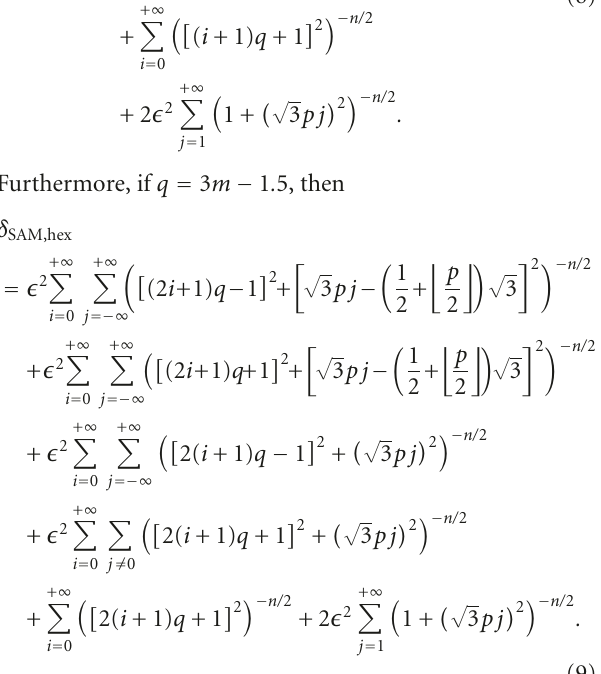
Figure 2: A network on the hexagonal grid with the spacing d hex meters between two adjacent nodes. Under the SAM, data pack- ets are transmitted from the black nodes to their neighboring gray nodes during a time slot. The horizontal spacing between two ac- tive transceivers is qd hex , and the vertical spacing between two active √ 3 pd hex . transceivers is Table 2: The ( p , q )-optimal network throughput in bits-hops/s/ Hz/node of a network on the hexagonal grid under the SAM and nonfading